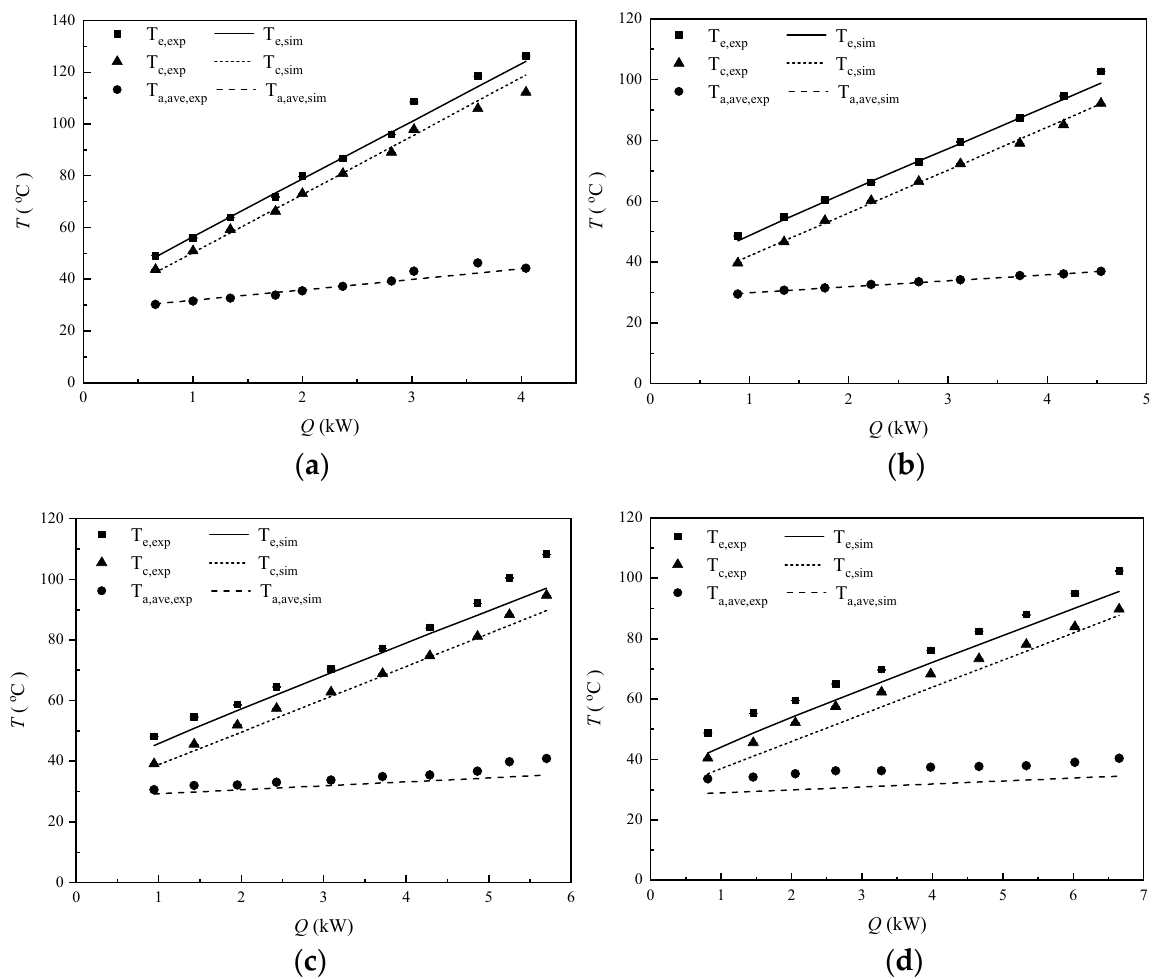
Figure 5. Comparison of experimental and theoretical temperatures of the evaporator and the condenser, and the average cooling air temperatures, under ( a ) 400 CMH, ( b ) 800 CMH, ( c ) 1200 CMH and ( d ) 1600 CMH. The effective thermal conductivity of the thermosyphon was evaluated for this condi- tion according